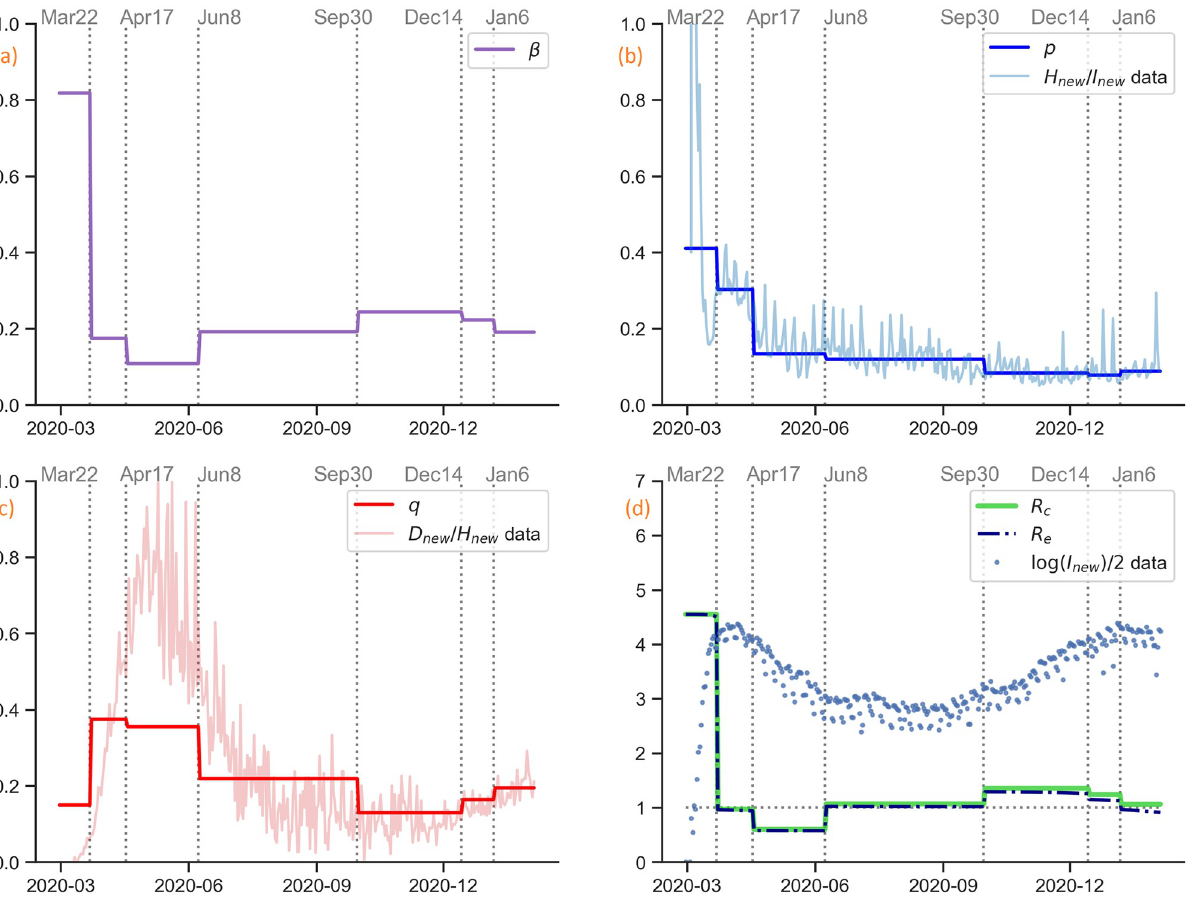
Fig 8. Estimation of parameters and reproduction numbers. (a) Estimated time-dependent transmission rate β ( t ). (b) Estimated time-dependent hospitalization ratio p ( t ), compared with daily hospitalizations over daily cases calculated from the raw data. (c) Estimated time-dependent death from hospital ratio q ( t ), compared with daily deaths over daily hospitalizations calculated from the raw data. (d) Estimated control reproduction number R and effective reproduction number R calculated by the estimated parameters, compared with 1/2 of the logarithm of daily cases. e